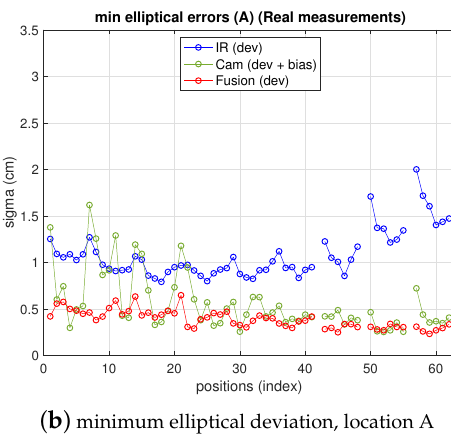
Figure 12. Pixelic errors in target detection at each position, all illumnation range.